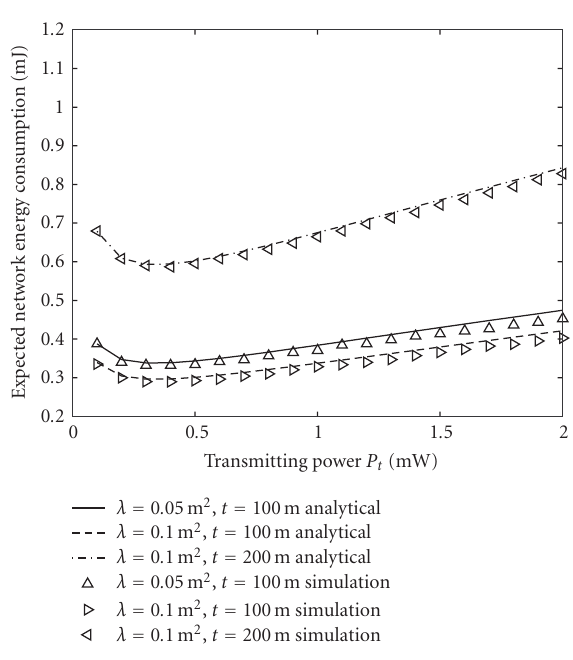
Figure 10: Network energy consumption versus transmitting power P t .